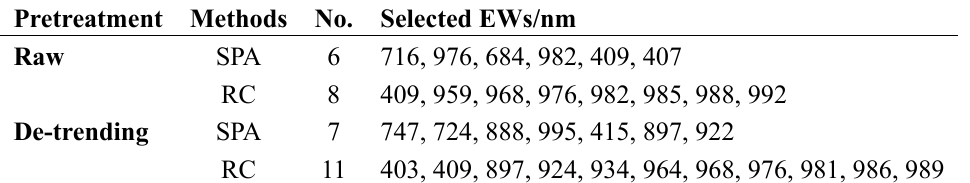
Table 3. The selected EWs by SPA and